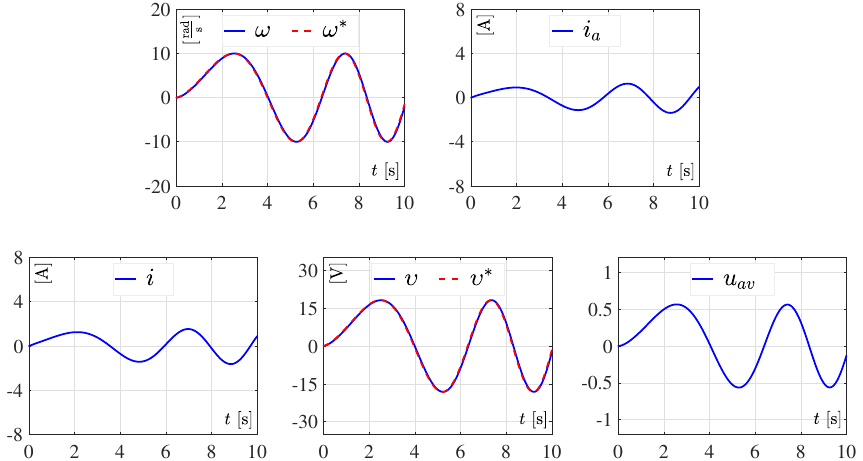
Figure 12. Simulation results of the system in closed-loop when the fourth desired trajectory for ω ∗ , determined by (25), is taken into